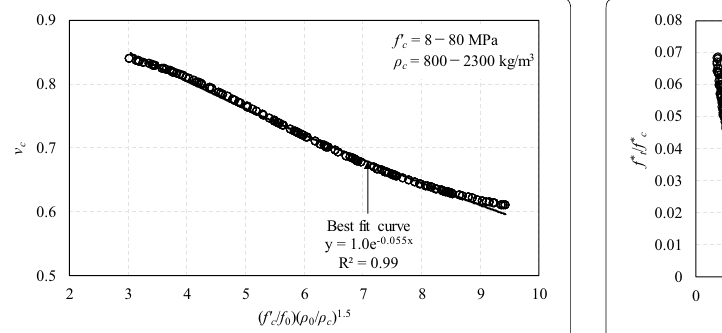
Fig. 5 Modeling of ν c for LWAC‑BS.